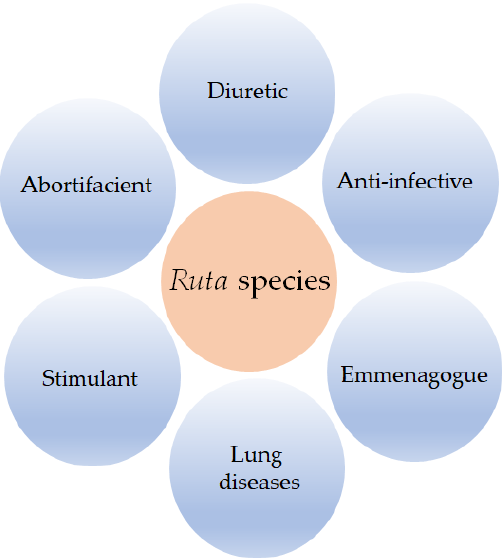
Figure 1. Major medicinal applications of Ruta species in traditional medicines.